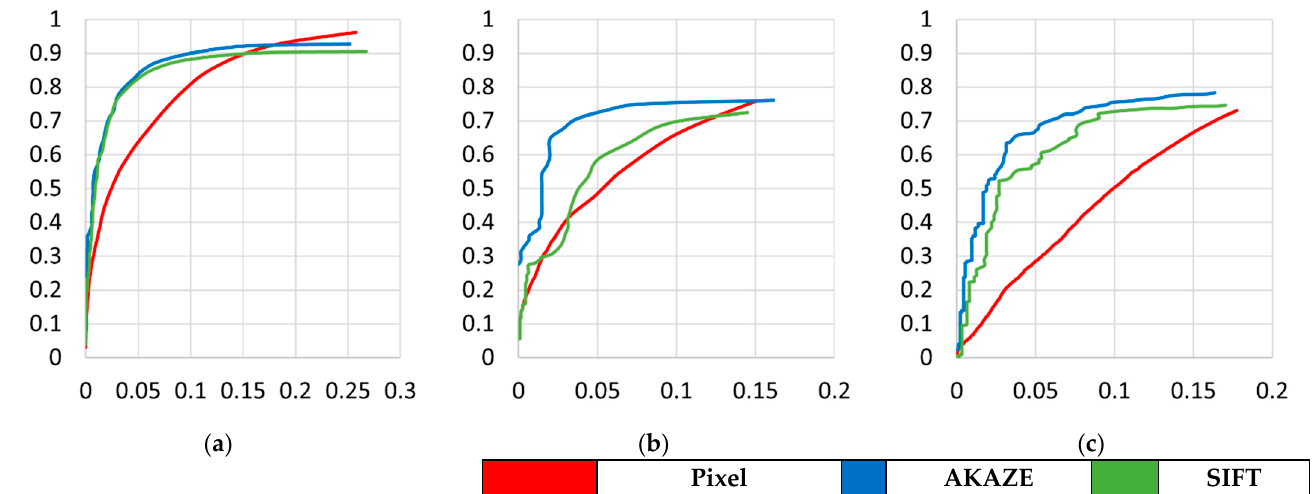
Figure 11. The ROC curves for pixel-based and feature point-based change in ( a ) Incheon, ( b ) Chilgok, and ( c ) Seoul. X -axis represents false alarm rate and Y -axis recall. Table 5. Performance of pixel-based and feature-based change detection in the reference objects.